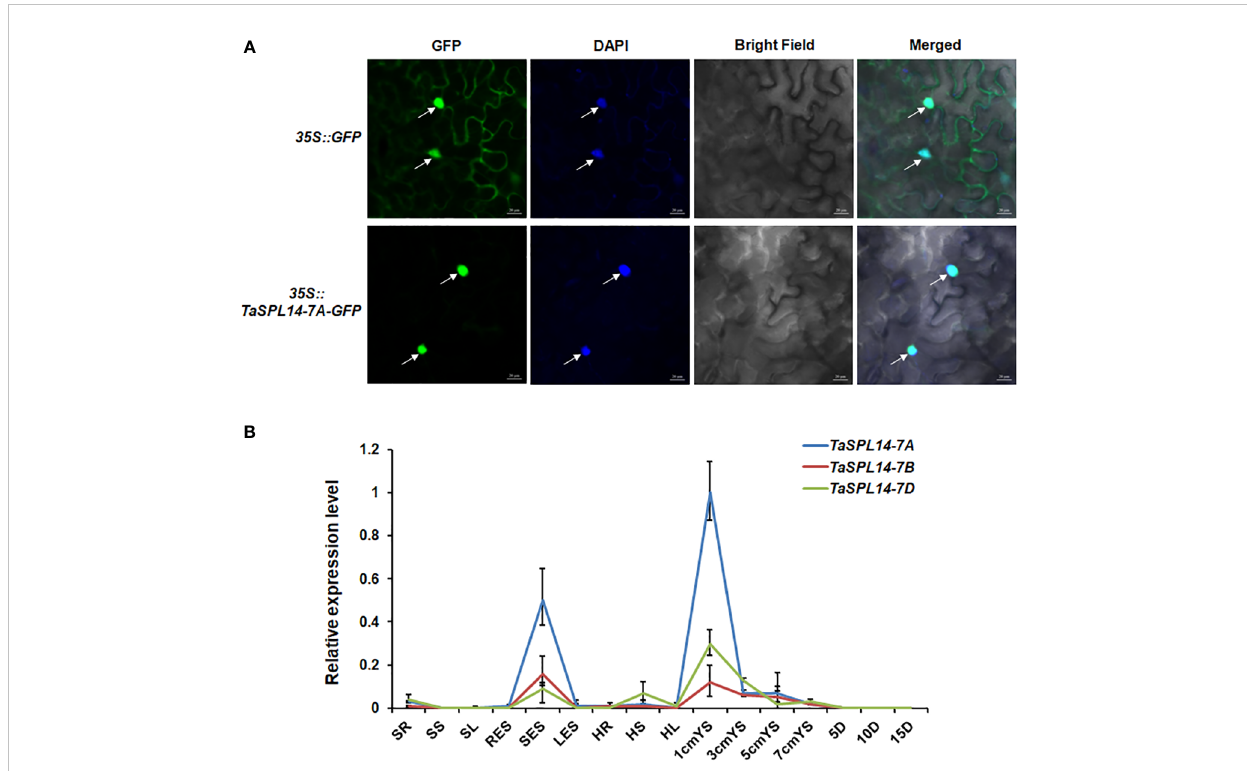
FIGURE 2 Characterization of TaSPL14 homoeologs. (A) Subcellular localization of TaSPL14-7A in tobacco leaves. GFP and TaSPL14-7A-GFP fusions under the control of the CaMV 35S promoter were transiently expressed in tobacco leaves. The arrows indicate nuclei stained with DAPI. Bar = 20 µm. (B) Spatial and temporal expression patterns of the three TaSPL14 homoeologs in various Chinese Spring tissues. SR, seedling roots; SS, seedling stems; SL, seedling leaves; RES, roots at elongation stage; SES, stems at elongation stage; LES, leaves at elongation stage; HR, roots at heading stage; HS, stems at heading stage; HL, leaves at heading stage; 1cm – 7cmYS, 1 – 7-cm young spikes; 5D – 15D, grains at 5 – 15 days post-anthesis, respectively. Normalized values of TaSPL14 expression relative to Actin were given as mean ± SD from three replicates.